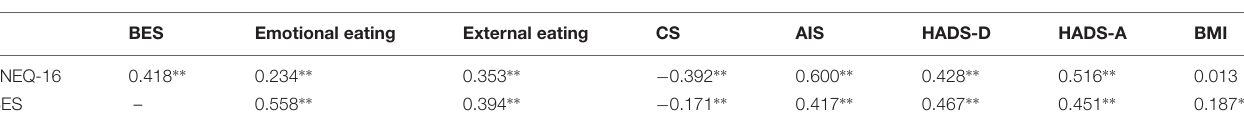
TABLE 4 | Correlations between measures ( n =